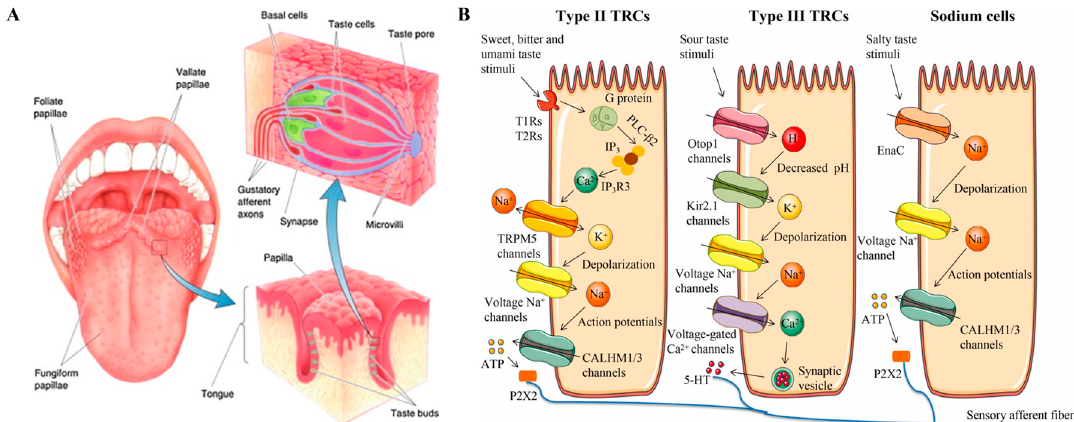
Figure 1. Schematic structure and taste transduction of the human taste-sensing system. ( A ) The distribution and structure of different papillae, taste buds, and taste cells of the tongue; ( B ) diagram of taste signal transduction in different types of taste cells responding to bitter, umami, sweet, sour, and salty compounds. Reproduced from [13,16] with permission from Elsevier.